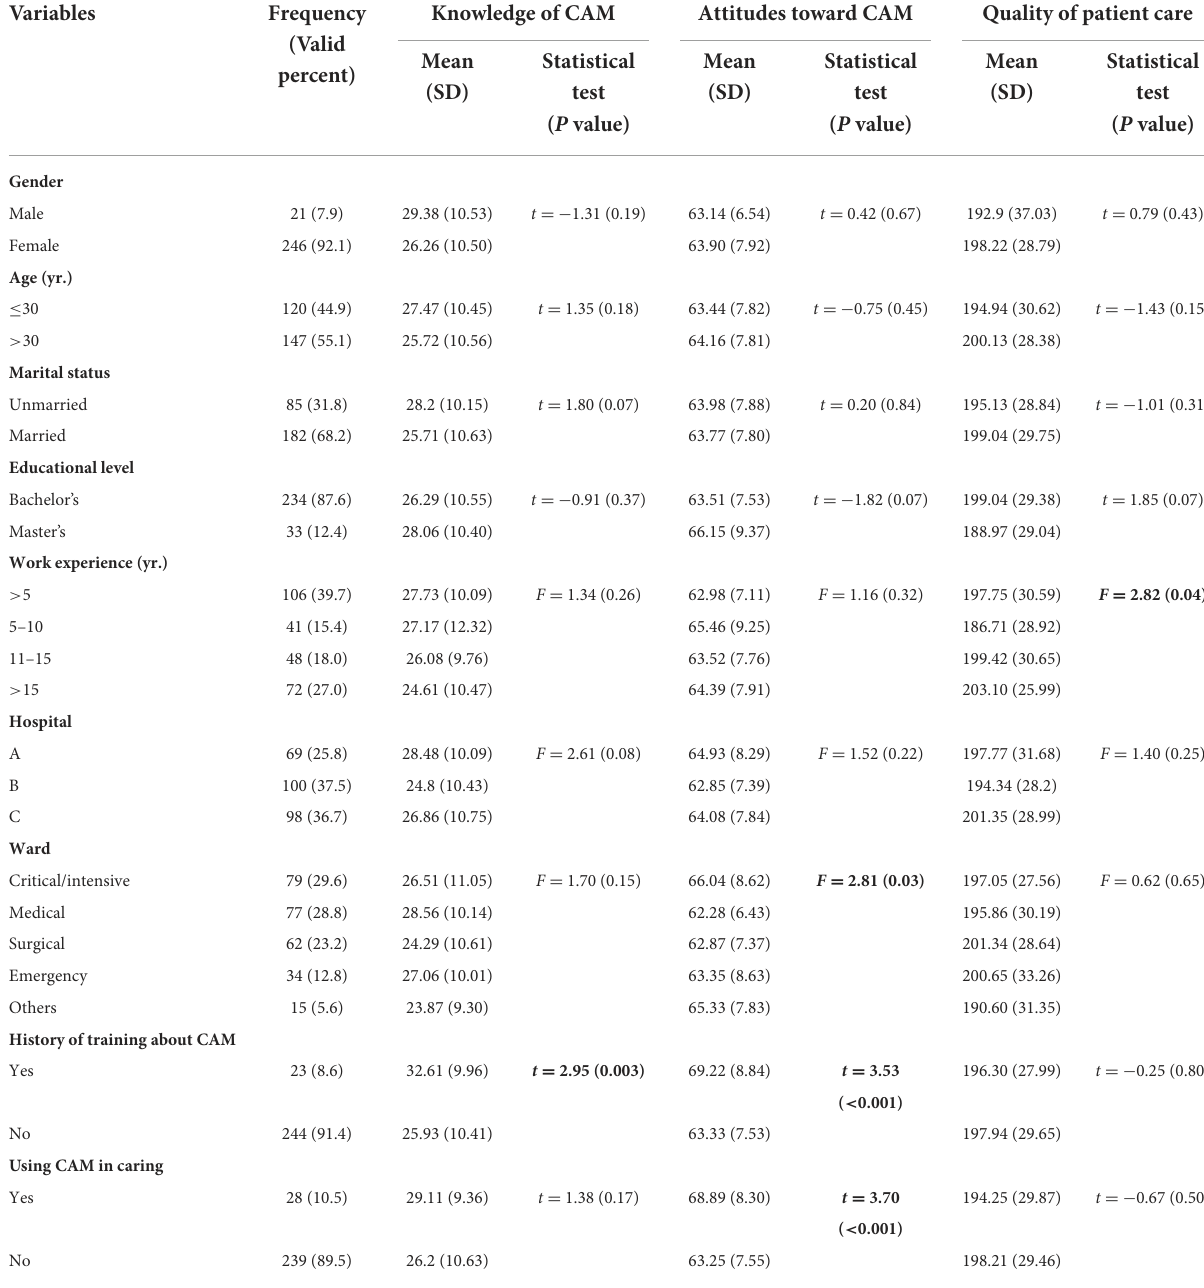
TABLE 1 Participants characteristics and the association between participants’ characteristics and knowledge of CAM, attitudes toward CAM, and quality of nursing care ( n = 267).